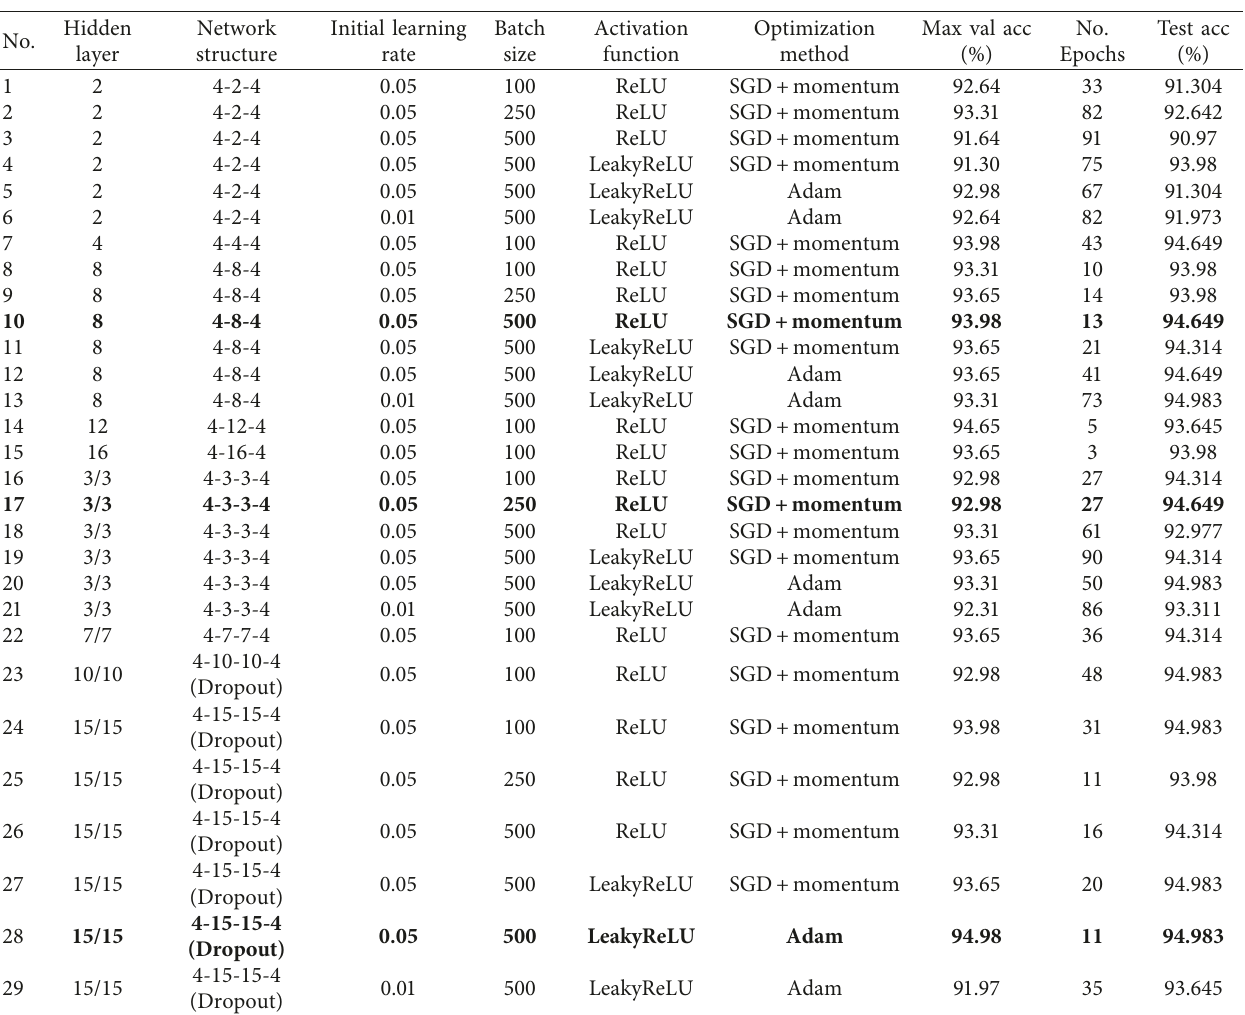
Figure 10: Schematic architecture of FCN. (a) 4-3-3-4. (b) 4-7-7-4. (c) 4-8-4. Table 5: Details of network training with different superparameter